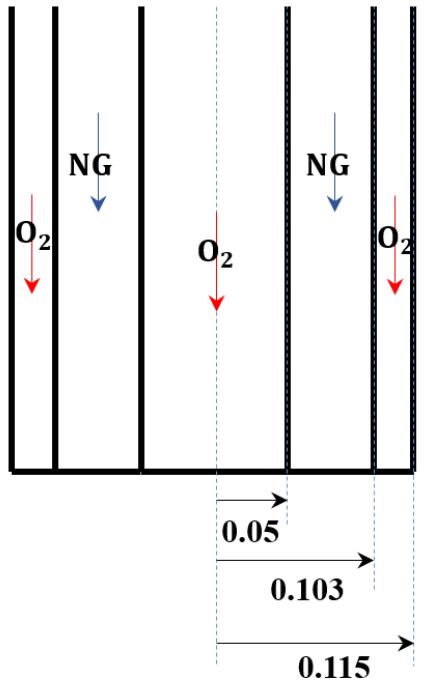
Figure 17. Burner configuration and dimension (unit in m).